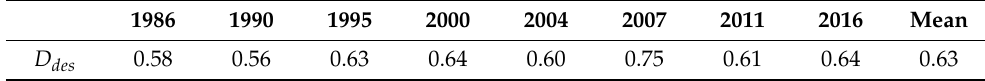
Figure 4. Change of desertification index with longitude in OSL. Table 1. Desertification index and mean value of OSL. Table 1. Desertification index and mean value of OSL.